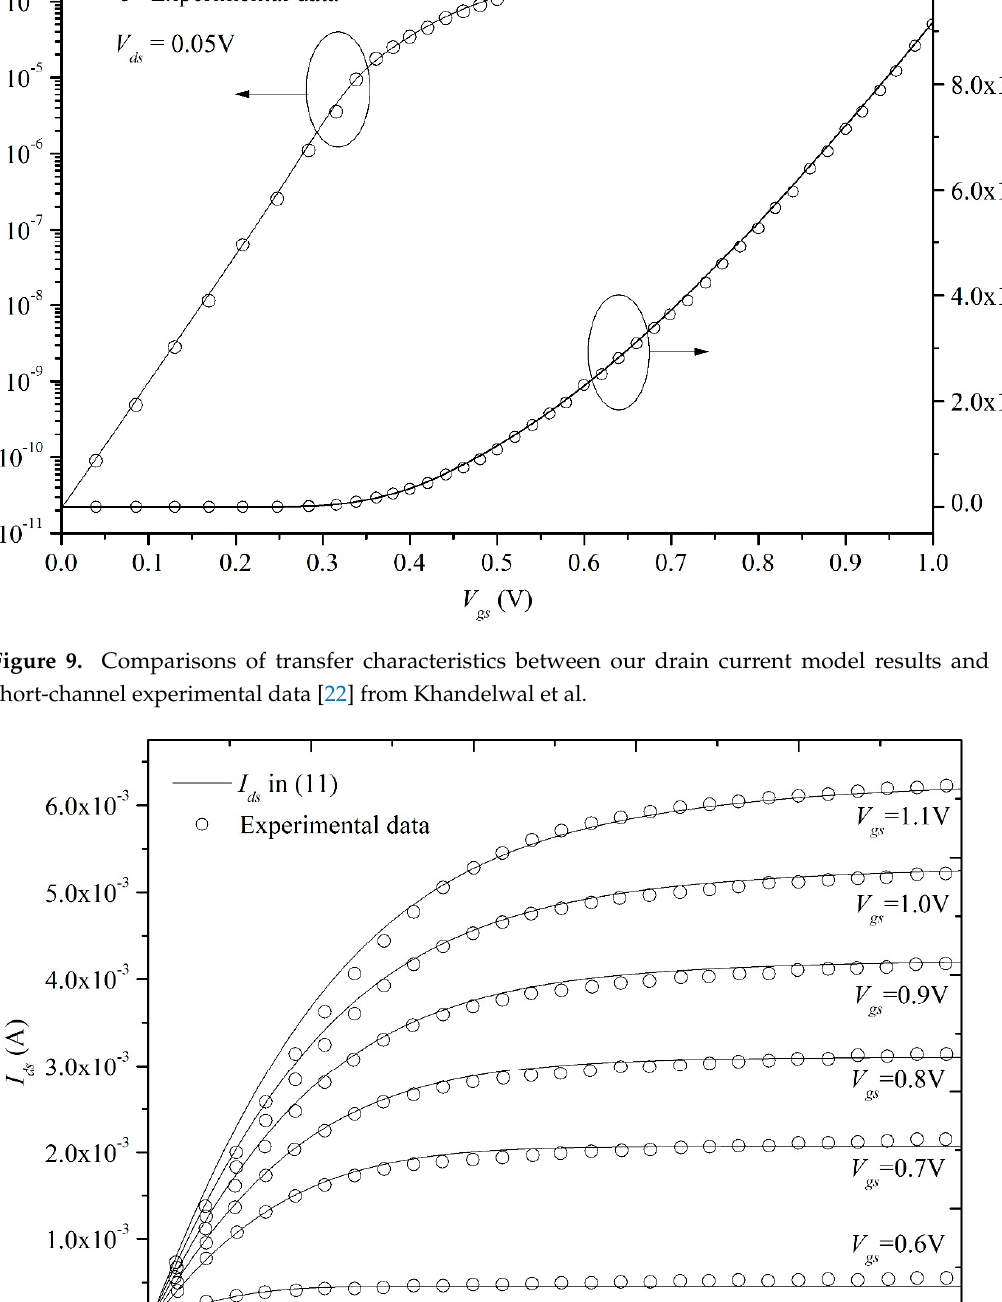
Figure 7. Comparisons of output characteristics between our drain current model results and short-channel experimental data [22] from Khandelwal et short-channel experimental data [22] from Khandelwal et al.